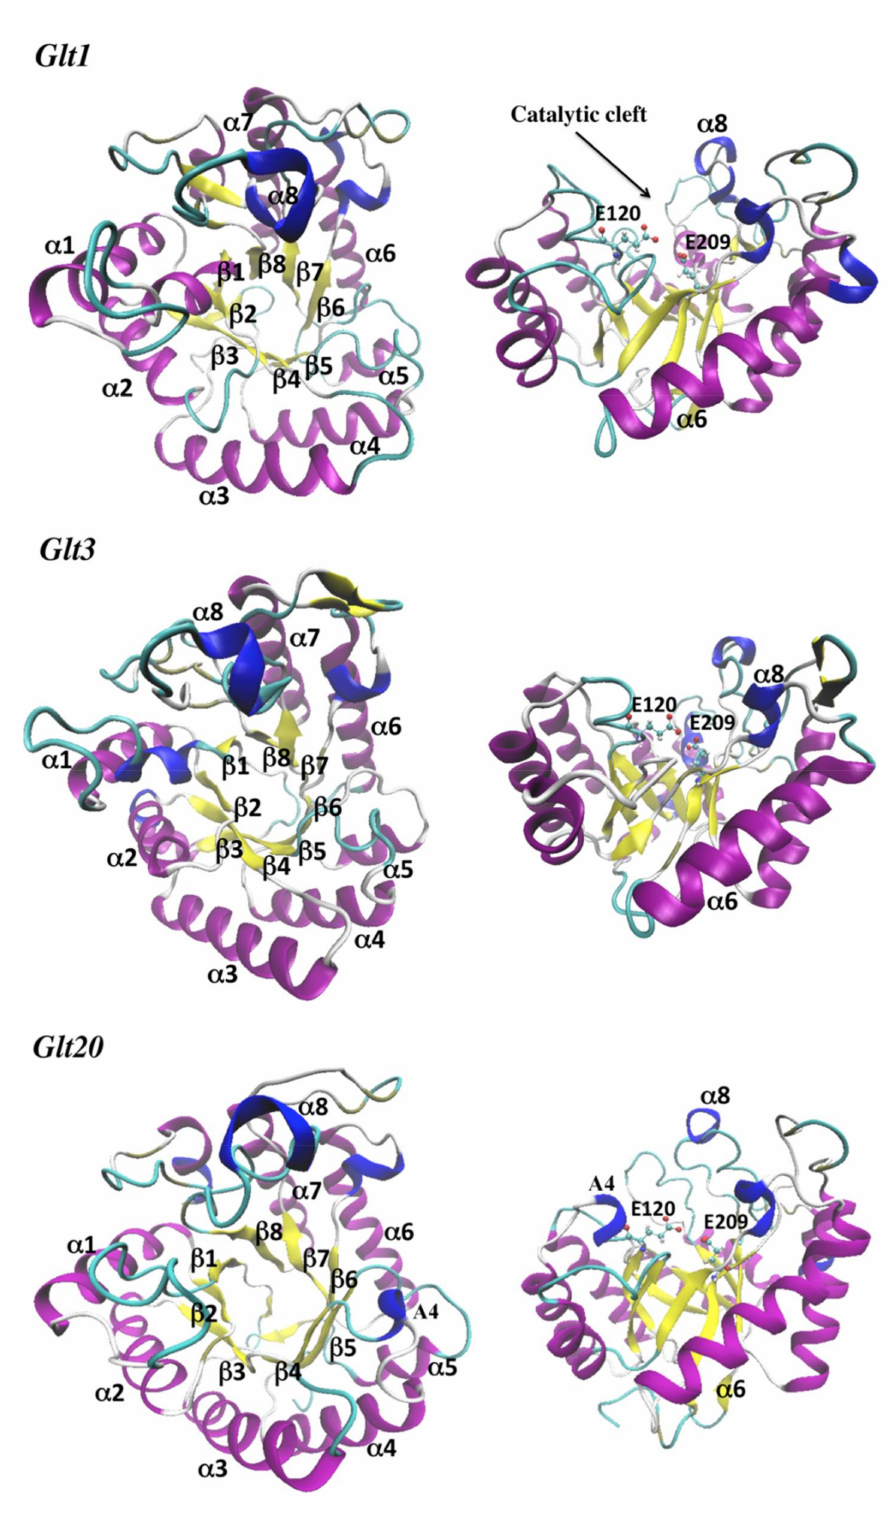
Figure 2. Modeled overall structures of the models obtained for Glt1, Glt3 and Glt20. The ( α / β ) 8 classical TIM-barrel fold is represented as a ribbon diagram. A front view of the TIM-barrel is shown to the left and a side view to the right. The catalytic amino acids are shown in the lateral views using CPK representation, α helixes are in purple, 3 10 helixes in blue, β -strands in yellow, coil in white and turns in cyan. Notice that A4 helix is present in